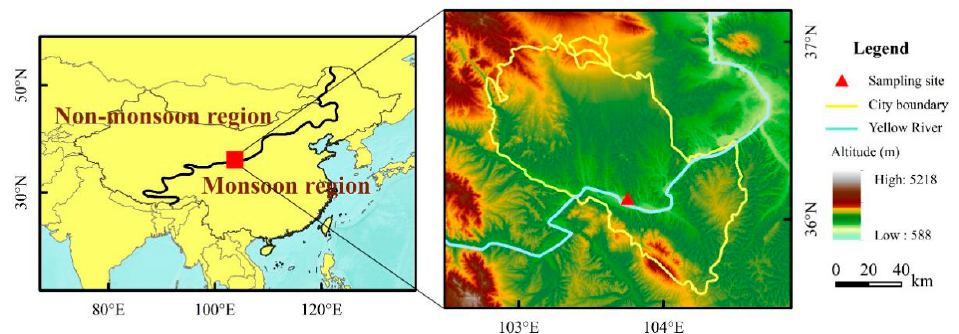
Figure 1. Map showing the location of the sampling site in Lanzhou City.